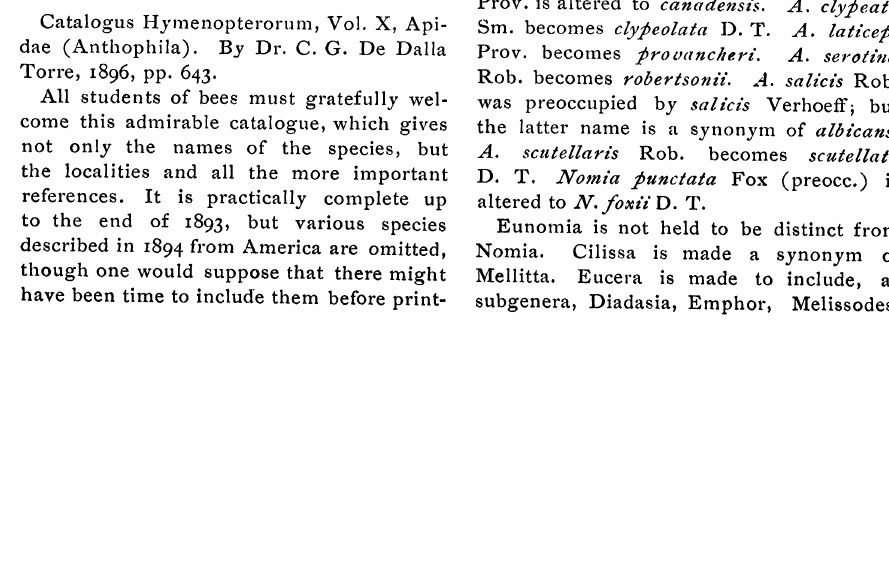
green, an irregular, but distinct geminate, shaded greenish white dorsal band, broaden- ing out and filling in all the dorsal space on joints 2 to 4, still obscurely darker centered. All the space below the subdorsal line like- wise completely filled in with the same greenish white, with the paler secondary dots. Spiracles white with a median brick red band, except the one on joint 5 which is white with a black spot at its posterior side. The side color of the body is cut by darker green oblique shades which run fl’om the posterior edge of each segment on the sub- stigmatal line upward and forward (in the reverse direction from what is usual in line is distinct from the anal feet forward to joint I, white and yellow like the subdorsal line and also shaded with pink. Forward of joint I it becomes faint and is scarcely distinguishable in front of joint 8.